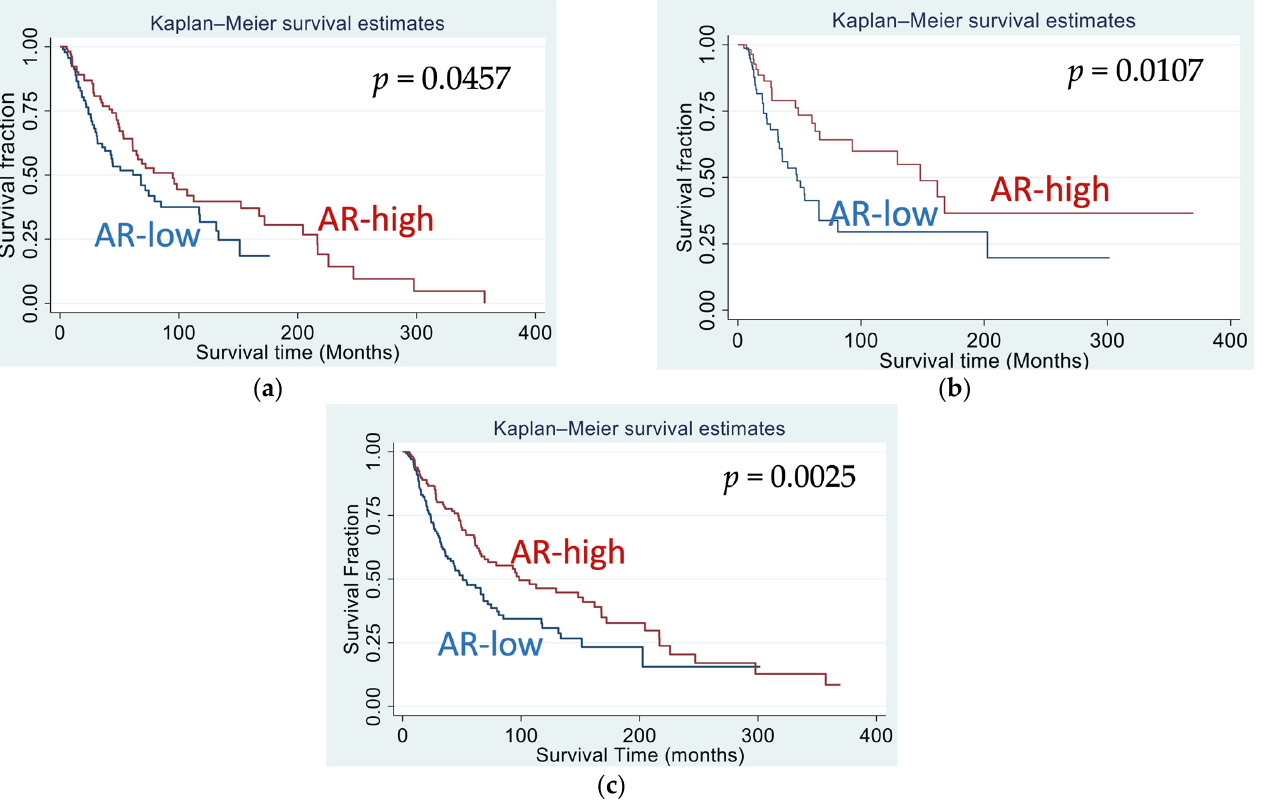
Figure 1. Kaplan–Meier survival curves for patients with high and low AR protein levels. ( a ) For both male and female patients; ( b ) for female patients; ( c ) for male patients ( p values are derived from log rank test). Table 3. AR is significantly associated with overall survival in melanoma